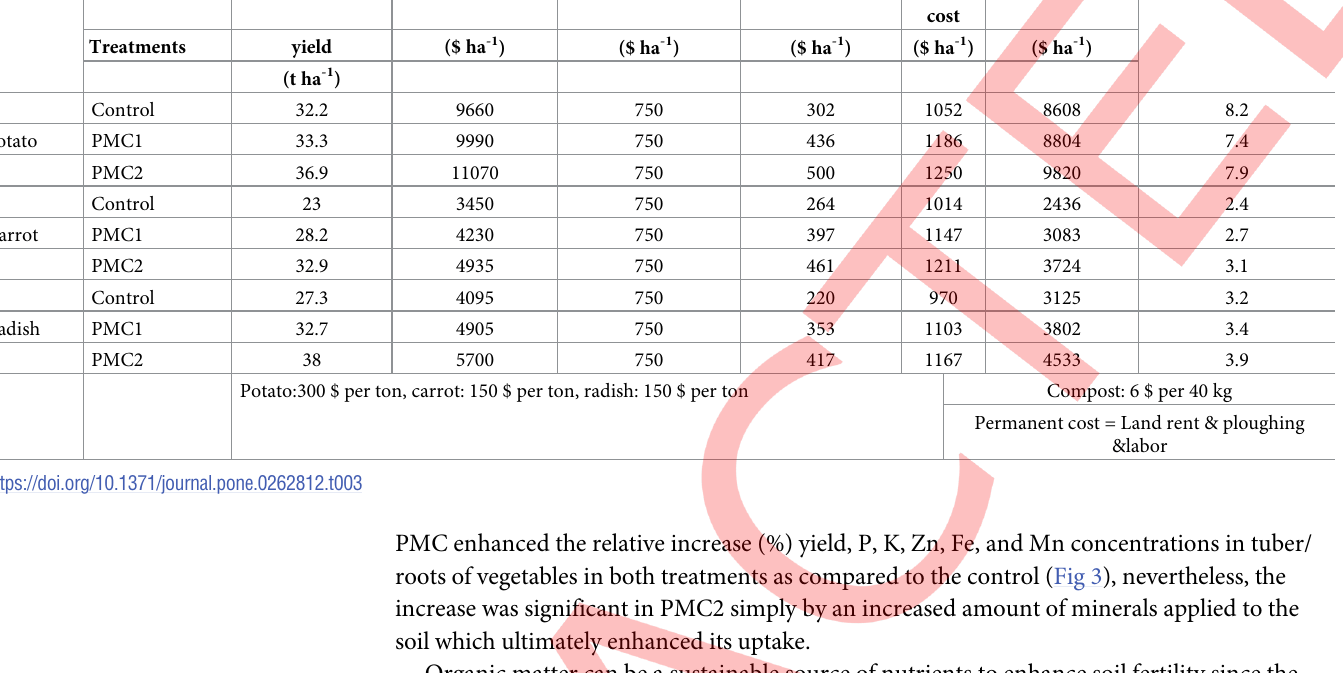
Table 3. Economic analysis of poultry mortality compost application on potato, carrot and radish experiment. Three levels of compost, 0 (Control) 1250 kg compost ha -1 (PMC1) and 1850 kg compost ha -1